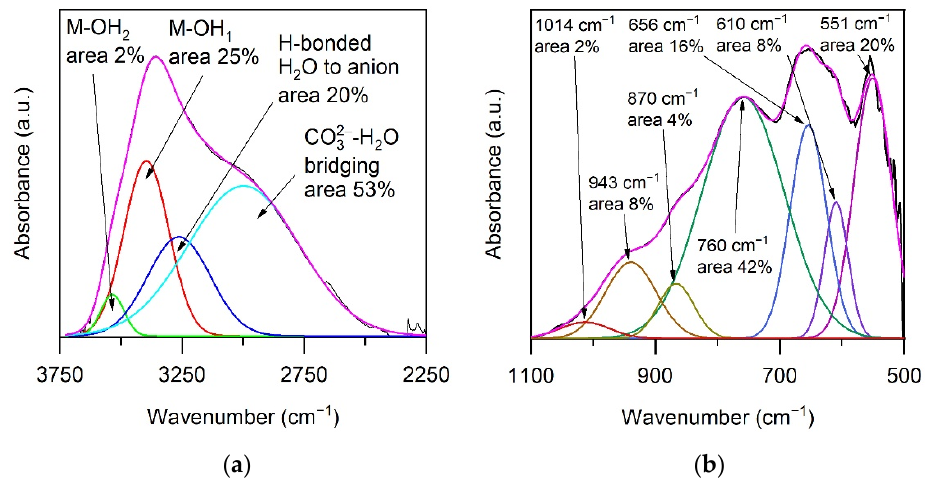
Figure 4. Deconvolution analysis of the ATR-FTIR spectra from ( a ) 3750 to 2750 cm − 1 and ( b ) 1100 to 500 cm − 1 of fresh sample C10-4.5. The Violet curve represents the sum of all deconvoluted signals. In black, the experimental curve.